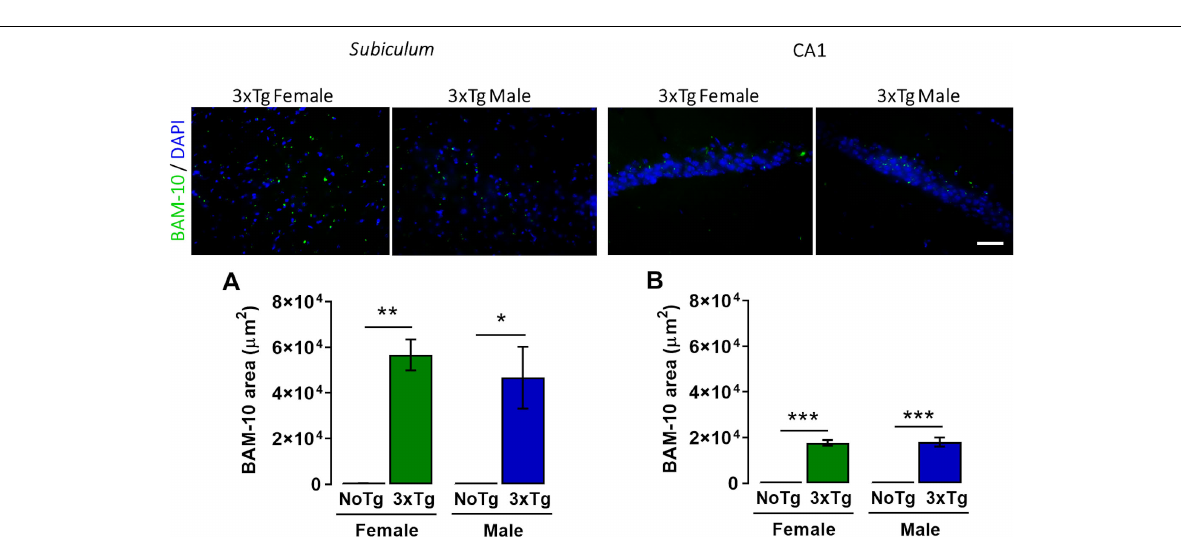
Frontiers in Neuroscience |